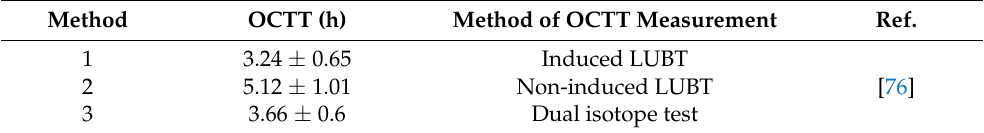
Table 2. The OCTT value